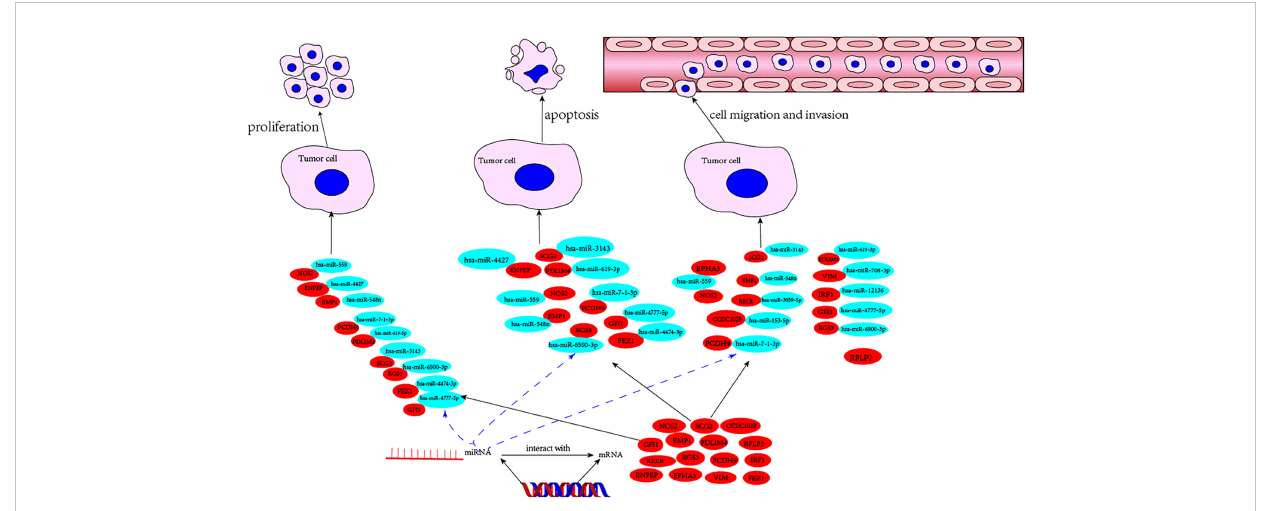
FIGURE 6 The mechanism diagram of potential TME prognostic genes and associated miRNAs for breast cancer